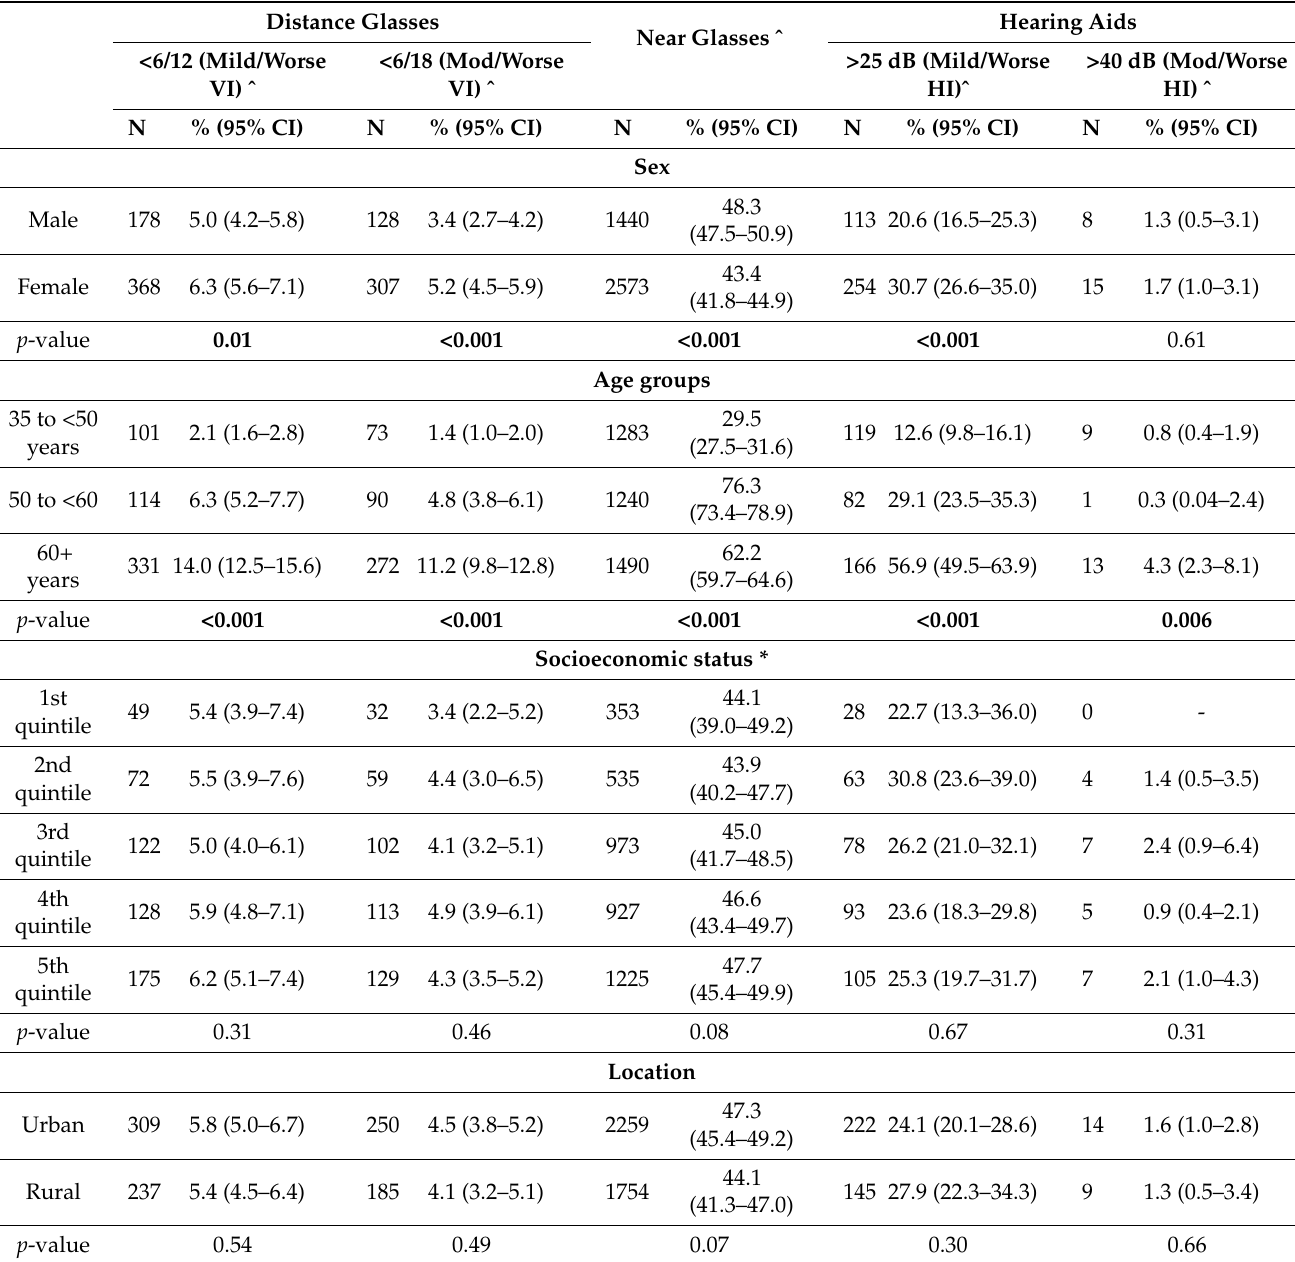
Table 3. Total need for distance glasses, near glasses, and hearing aids stratified by sex, age, socioeconomic status and urban/rural in The